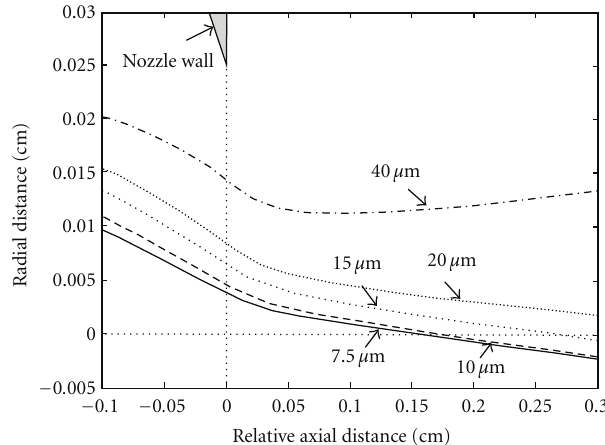
Figure 11: Diagram of trajectories for 7.5–40 μ m diameter particles exiting a 500 μ m nozzle, reprinted from Mallina et al. [47], Copyright 1999, with permission from